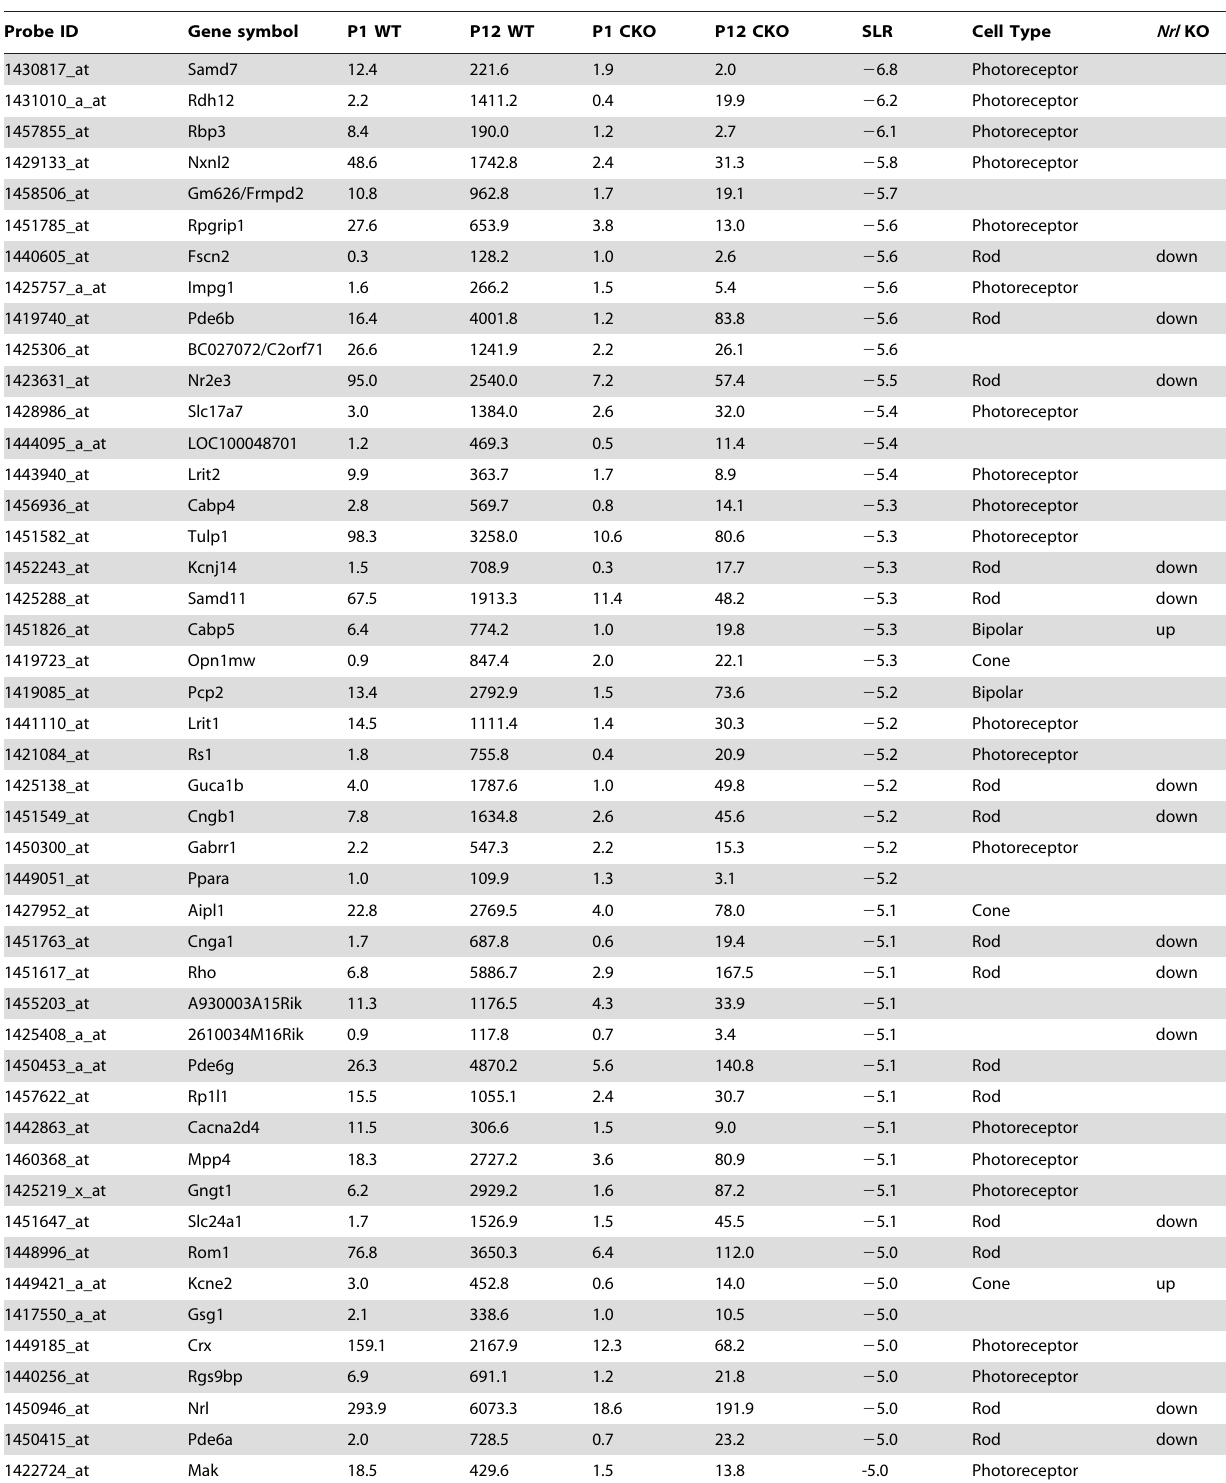
Table 1. Genes down-regulated in the Otx2 CKO retina (signal log ratio #2